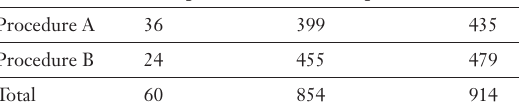
Table 2 Numbers of patients exhibiting or not exhibiting a post-op- erative complication after two surgical procedures in a new